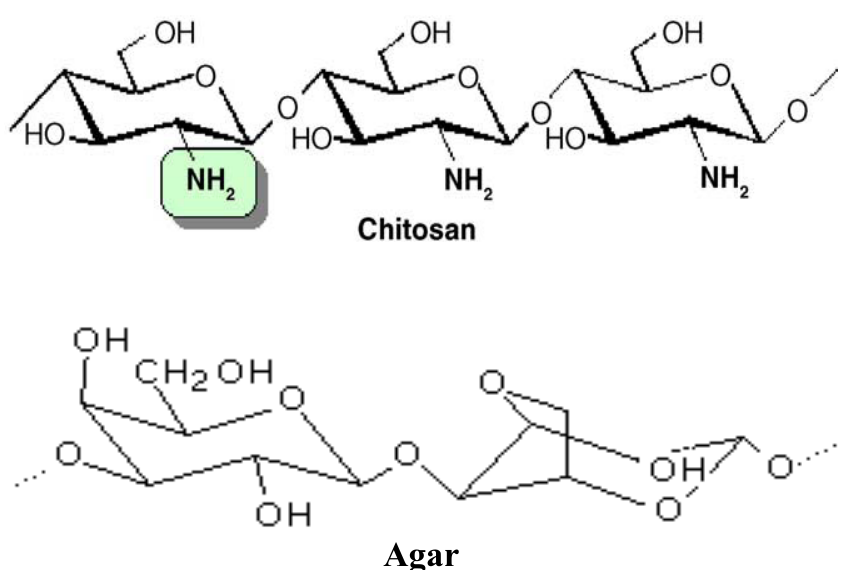
Figure 1: Chemical structure of chitosan and